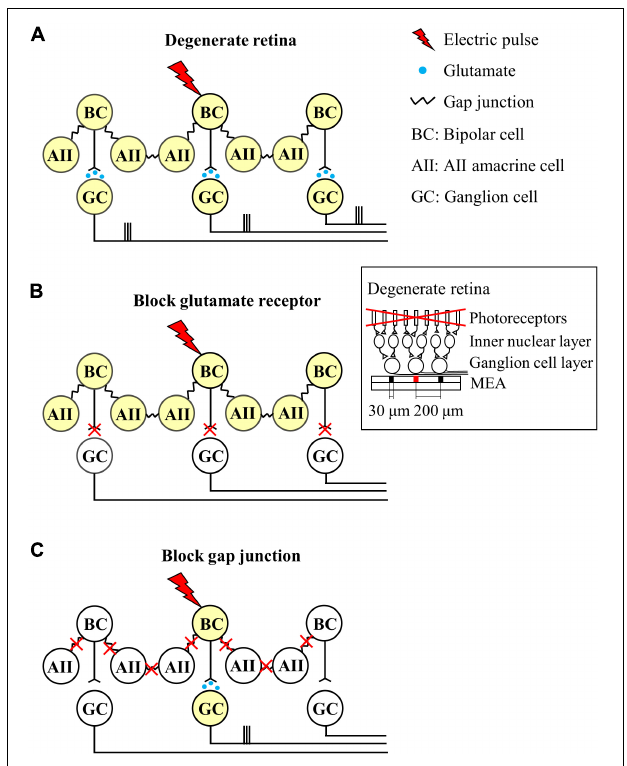
FIGURE 7 | Schematic diagram of the neuronal mechanisms of spatially extended RGC responses in the degenerate retina. Different colors indicate whether the neuron is activated or not (white: no activation, yellow: activation). (A) Network response of the degenerate retina to electrical stimulation. Electrical stimulation activates the central bipolar cell, which excites synaptically connected RGC. The bipolar cell also activates AII amacrine cells through gap junction coupling, resulting in network activation. The network activation of the inner nuclear layer leads to widespread activation of remote RGCs. (B) Blockade of excitatory input to RGCs. (C) Decrease in gap junctional connectivity results in focal activation of bipolar cells and RGCs, but not extensive network activation. Therefore, RGC activity is localized in a confined area similar to the wild-type retina. Inset represents the schematic cross-section of the degenerate retina-MEA assembly. The retina is placed on top of the MEA with the RGC layer down. One central electrode (shown in red) is used for electrical stimulation, while all the others for recording electrically evoked RGC spikes. Electrode diameter = 30 µ m, inter-electrode distances = 200 µ